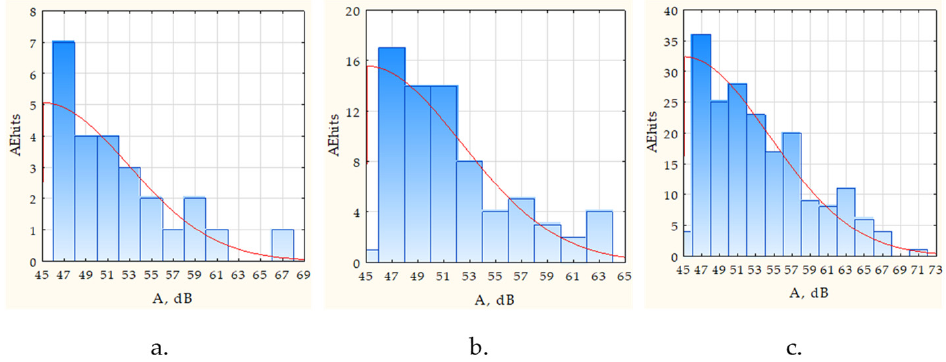
Figure 10. Distribution of AE hits amplitudes for a specimen with defect at various load values 15 kN ( a ); 30 kN ( b ); 45 kN ( c ).